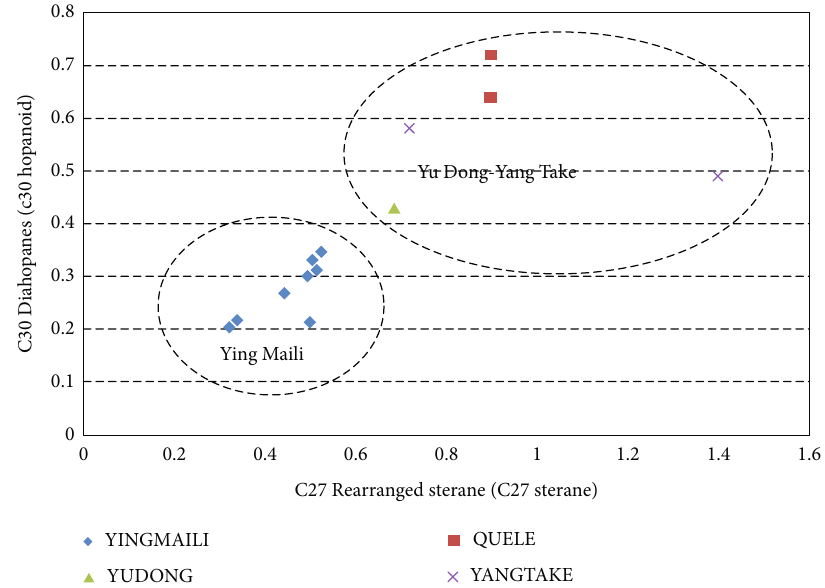
Figure 4: Crossplot of ratios of C30 rearranged hopane/C30 hopane and C27 rearranged sterane/C27